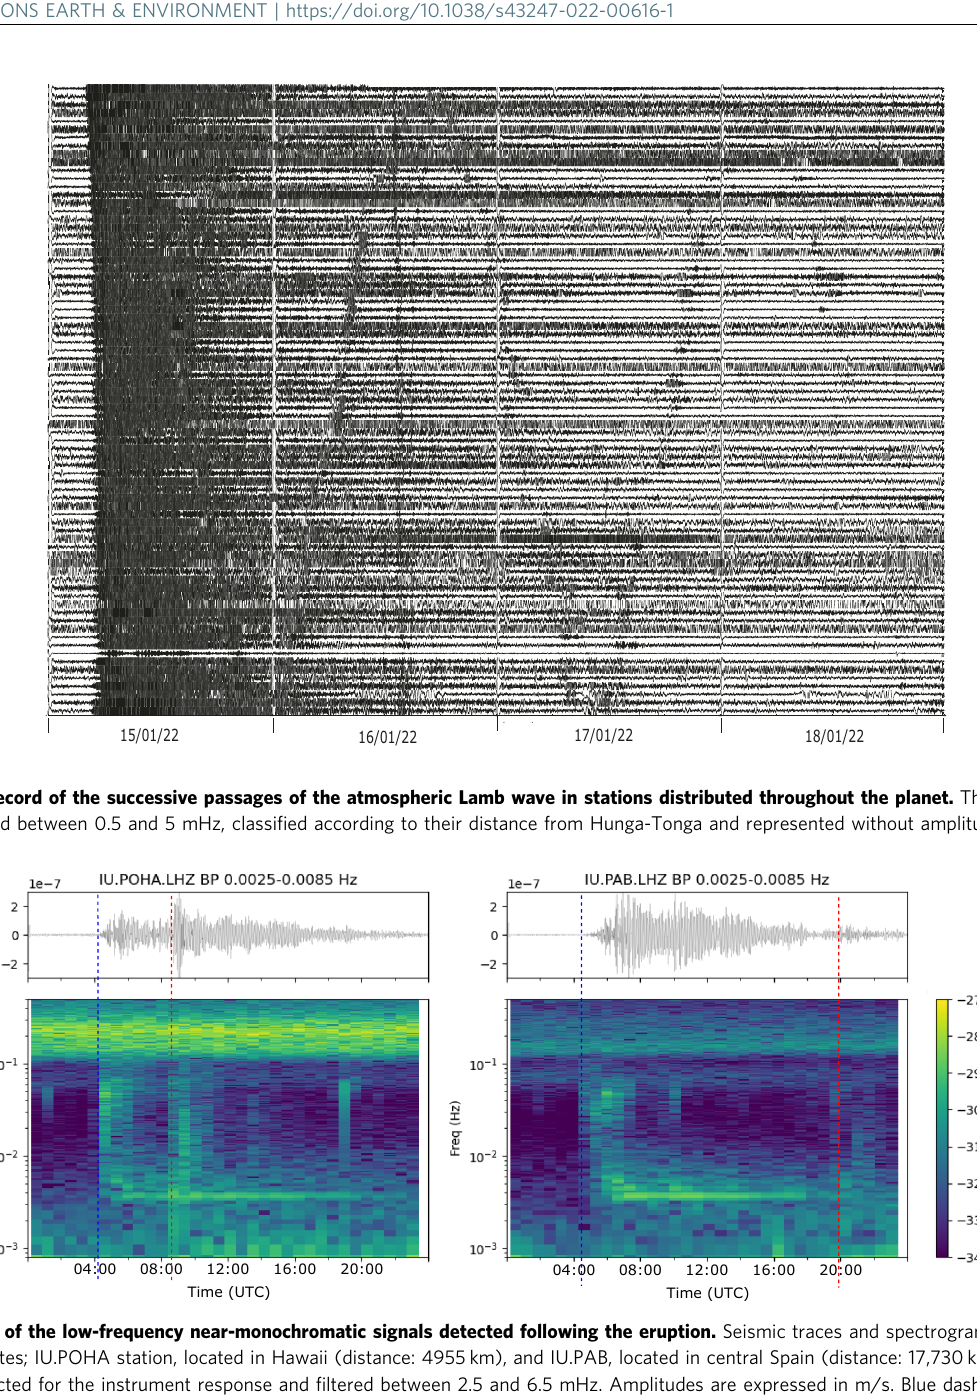
seismic trace and the corresponding spectrogram for two stations located at different epicentral distances, POHA (Pohakuloa, Hawaii), at 4955 km, and PAB (San Pablo, central Spain) at 17,735 km. In both cases, the arrival of the seismic waves gen- erated by the volcanic explosion is shown with blue dashed lines.